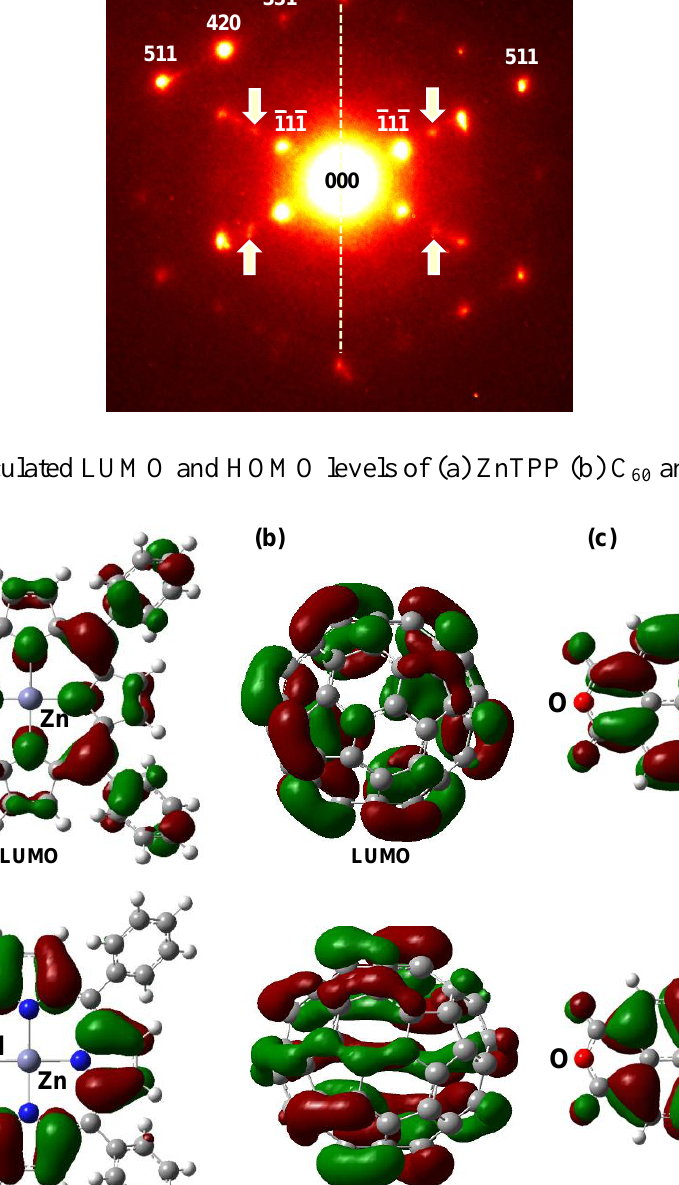
Figure 5. Electron diffraction pattern of ZnTPP:C